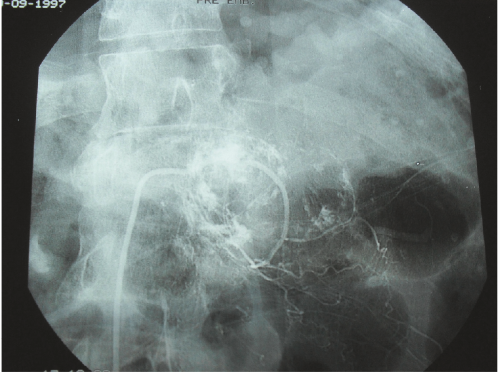
Figure 3: Embolization of the left L1 feeder.